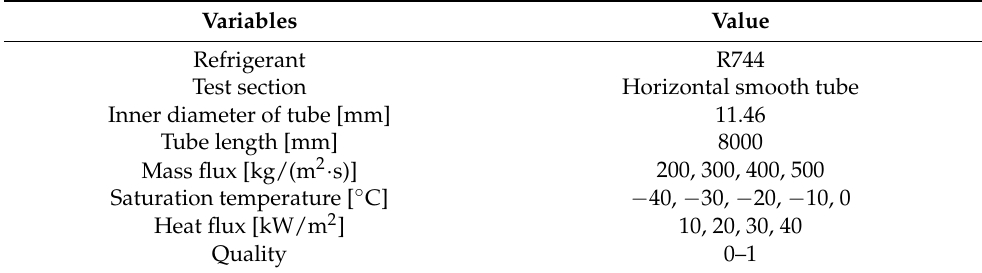
Table 2. Experimental conditions for R744 evaporation heat